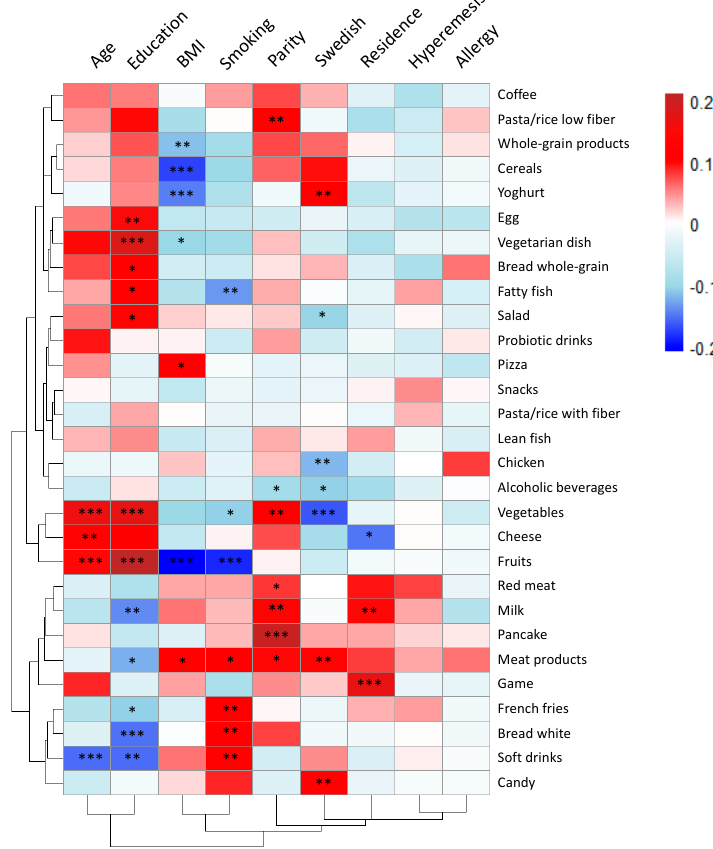
Figure 4. Heat map of correlations between food items and maternal characteristics ( N = 567). The magnitude of each correlation is denoted with a color, whereby the red color indicates a positive correlation and dark-blue color represents a negative correlation., such that the deeper the color, the stronger is the correlation. Univariate statistics were applied to reveal significant